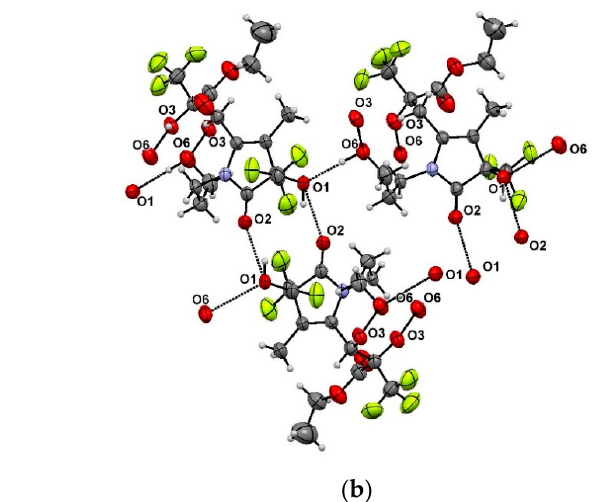
Figure 6. ( a ) The ORTEP view of compounds 11b according to XRD data; ( b ) crystal packing of 11b with indication of intermolecular hydrogen bonds.